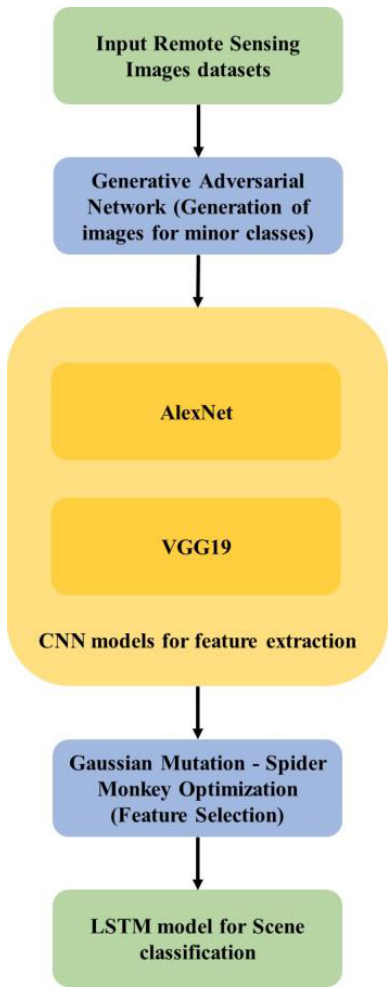
Figure 1. GM-SMO feature selection and CNN based feature extraction model for remote sensing scene classification.